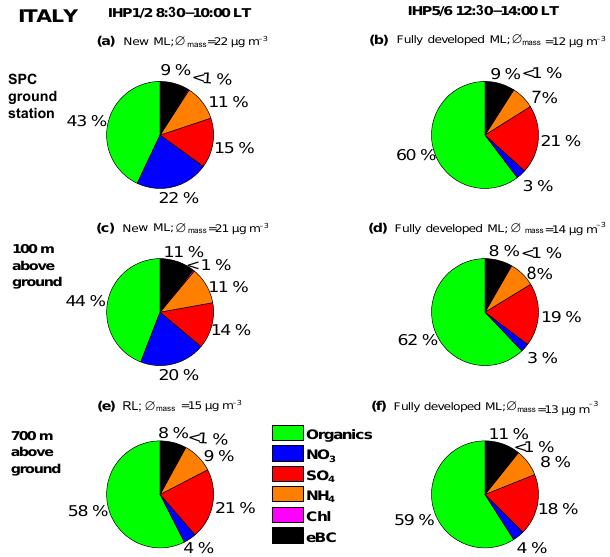
Figure 6. PM 1 chemical composition results from the flight on 20 June 2012 in Italy. (a, b) show the mass fractions measured by the HR-ToF-AMS and MAAP at San Pietro Capofiume ground sta- tion; (a) was recorded during IHP1/2 whereas (b) was measured during IHP5/6. (c–f) depict the mass fractions measured by the HR- ToF-AMS and aethalometer on the Zeppelin. (c and e) illustrate the results for the first height profiles, (c) at 100 and (e) at 700ma . g . l . , while (d and f) show the results for IHP5/6 for 100 and 700ma . g . l . ,